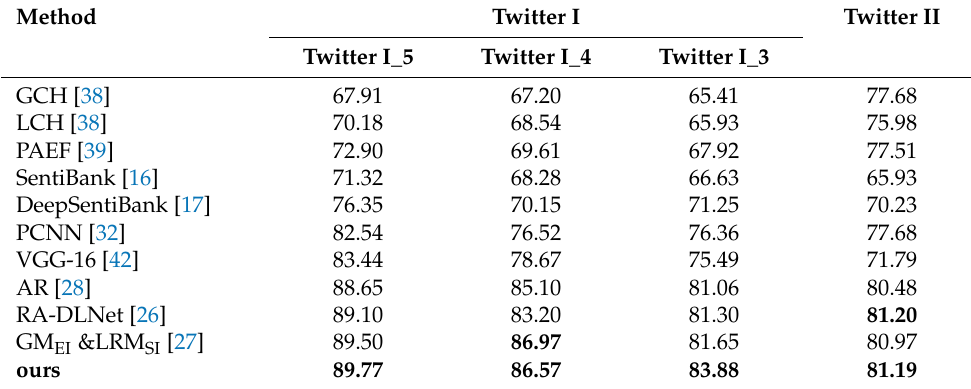
Table 4. Classification results of different state-of-the-art methods on twitter I and twitter II. The bold score is the highest score of each